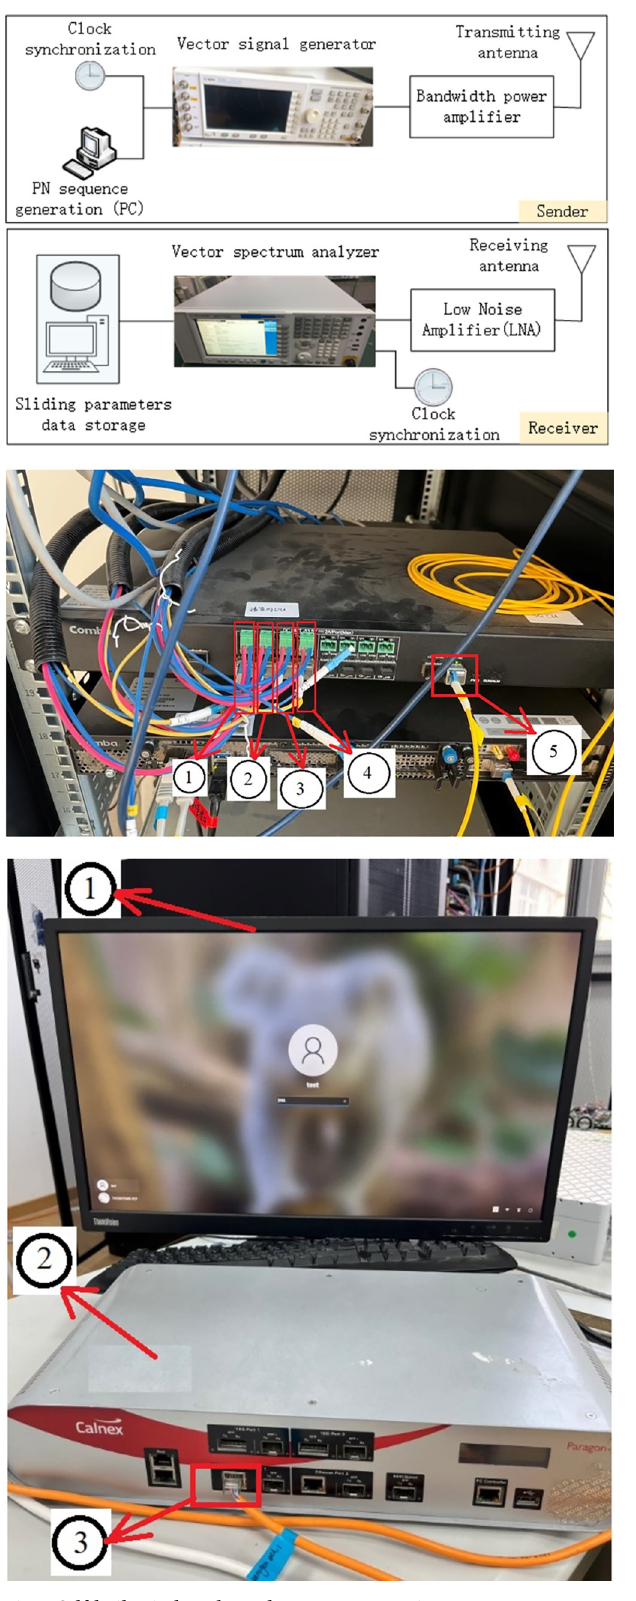
Fig 7. Self-built wireless channel measurement